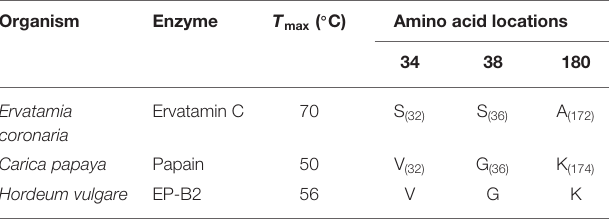
TABLE 1 | List of amino acid residues selected for introducing substitutions in Hordeum vulgare cysteine endopeptidase B2 (EP-B2) sequence.